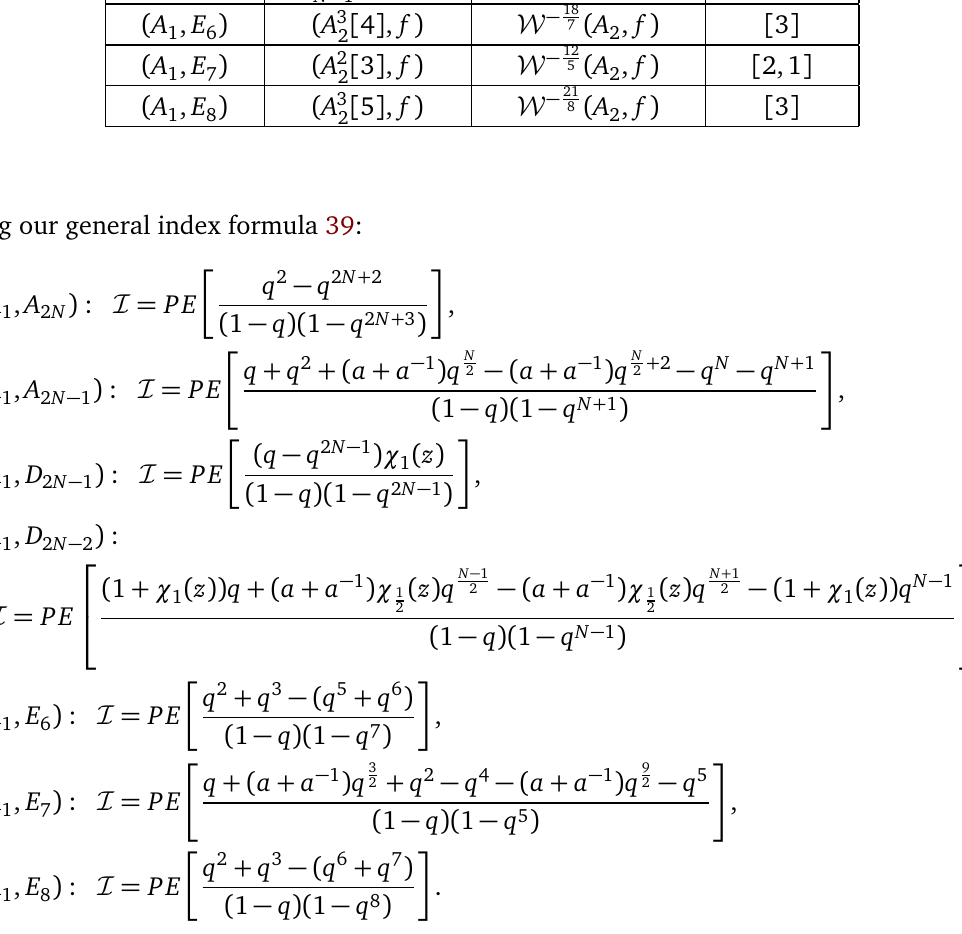
Table 5: The VOA of ( A